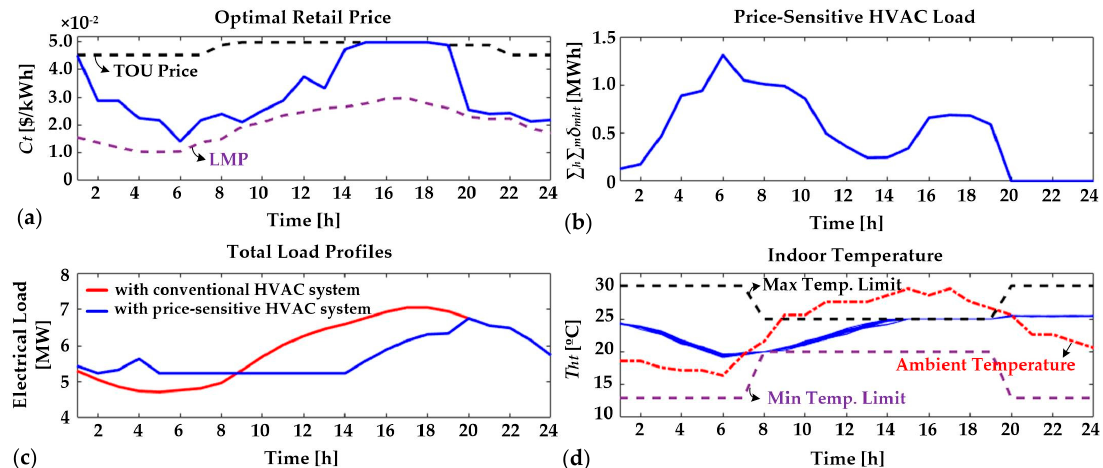
Figure 8. Optimal profiles for the proposed pricing strategy considering load leveling with the conventional load curve: ( a ) the optimal retail price, ( b ) total input power of the price-elastic HVAC systems, ( c ) total load profiles, and ( d ) indoor temperature variations in 15 building rooms.